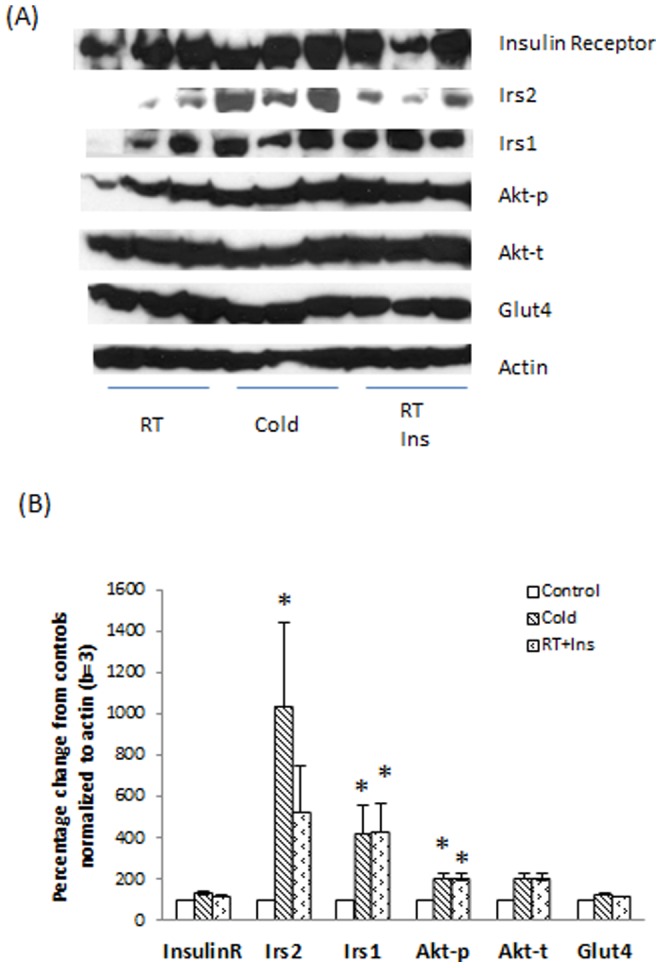
Western blot showing expression of the insulin receptor, Irs2, Irs1, Akt-p, Akt-t, Glut4, and Actin in the BAT of rats with/without stimulation.Nine rats were fasted overnight. The next morning, they were randomly exposed to one of three conditions: room temperature + saline (RT, control), cold temperature + saline (4°C for 4 hours, Cold), and room temperature with insulin administration (0.75 units/kg, RT+ins). The preparation of BAT lysates was performed as described in Materials and Methods. Panel A: Protein levels of Insulin receptor, Irs2, Irs1, Akt-p, Akt-t, Glut4, and Actin, analyzed and compared to controls. Panel B: Columns represent mean ± SEM protein levels determined from “A” as a percentage control values of three experiments (t-test with α = 0.05, * p<0.05). The insulin signaling pathway in the BAT of rats post the acute cold exposure was more active than controls with increased Irs2, Irs1, Akt-p post cold exposure.